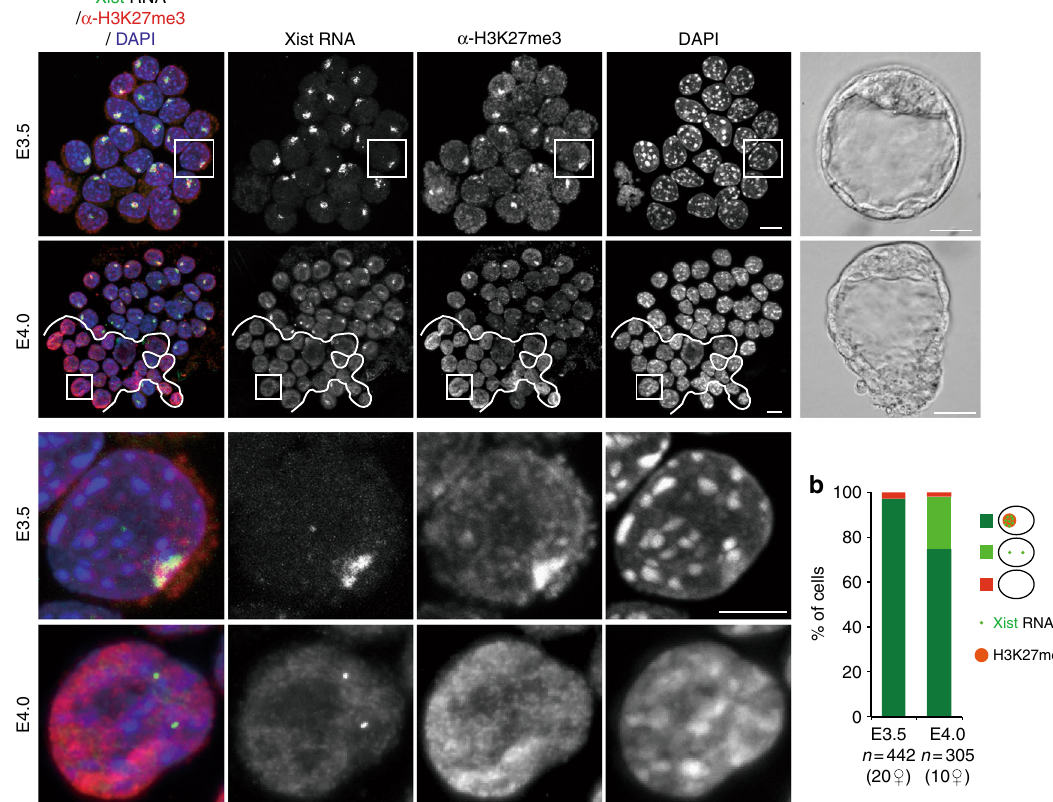
Fig. 1 Xist RNA and H3K27me3 pro fi les in the ICM cells of early and mid blastocysts. a Examples of individual ICM of early (E3.5) and mid (E4.0) pre- implantation stage embryos (photographs right panel, scale bar 20 µ m) analysed by immunolabelling with antibodies against H3K27 tri-methylation (red) combined with Xist RNA-FISH (green). For each stage, an intact ICM (scale bar, 10 μ m) and an enlarged nucleus (scale bar, 5 μ m) are shown (IF/RNA- FISH). The cells below the white line illustrate the cluster of cells that have lost Xist RNA coating and H3K27me3 enrichment on the Xp and are presumably the epiblast. b Proportion of ICM cells showing enrichment of H3K27me3 on the Xist RNA-coated X-chromosome in early and mid blastocyst stages are presented as mean (right panel). Below the graph, the total cell number analysed is indicated, followed by the number of female embryos analysed in brackets. ICM inner cell mass, RNA-FISH RNA- fl uorescent in situ hybridization, IF immuno fl